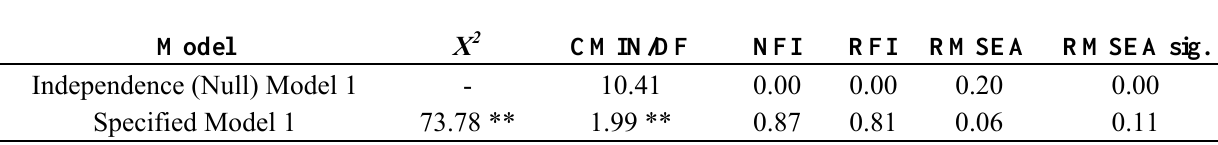
Table 4. Goodness-of-fit statistics for the final structural equation model of factors contributing to verbal memory